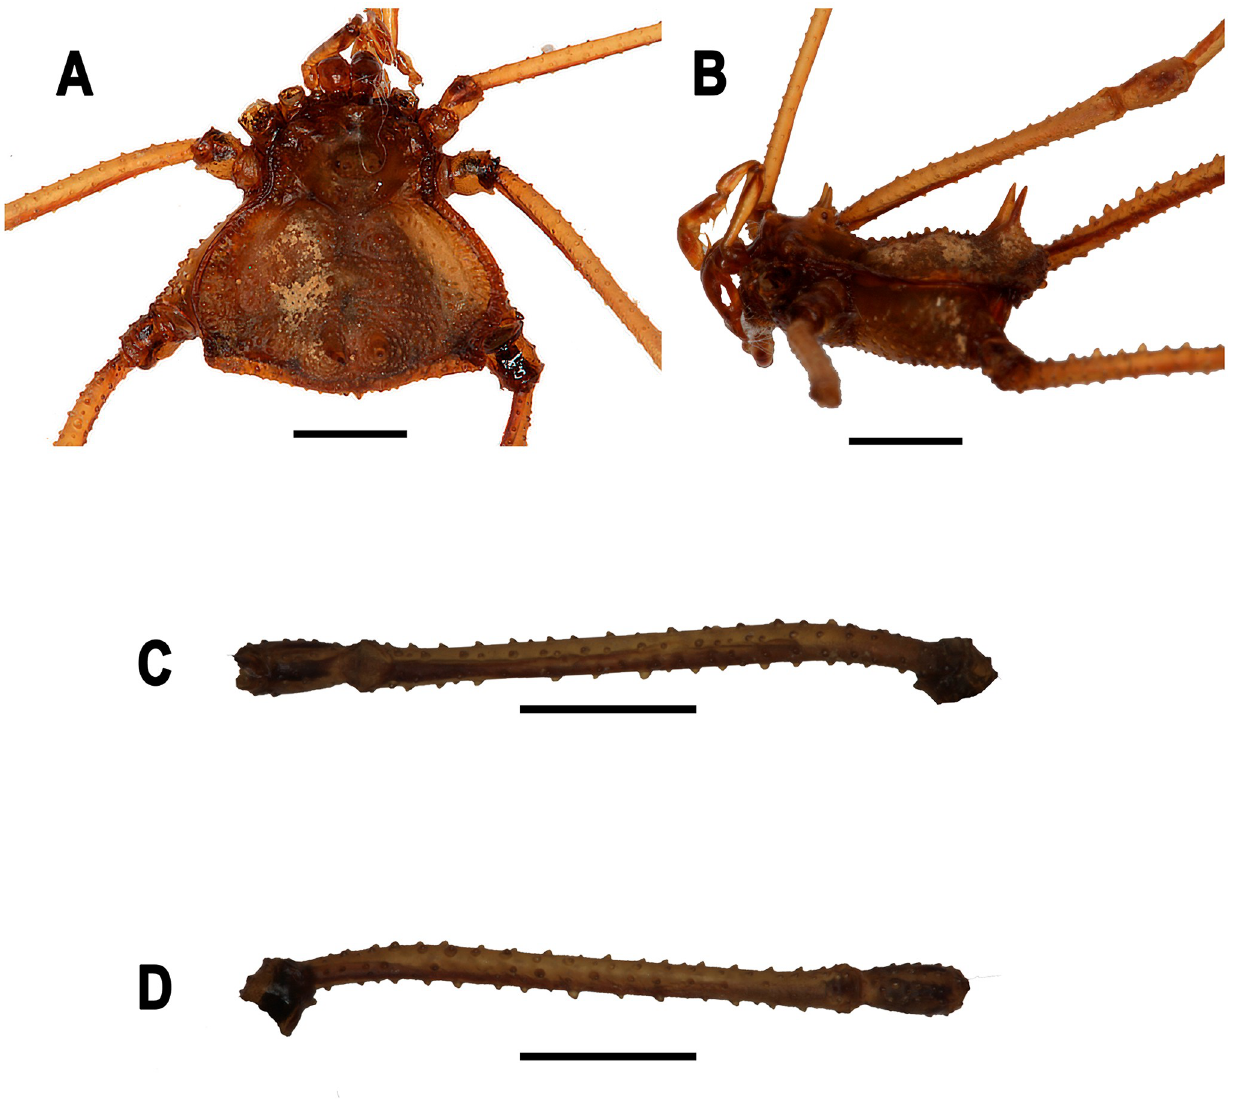
Fig 10. Neosadocus misandrus ( Metagonyleptes misandrus female holotype, IBSP 12). A. Dorsal view. B. Left lateral view. C–D. Right trochanter–patella IV (C: retroventral view; D: dorsal view). Scale bars: 3 mm.